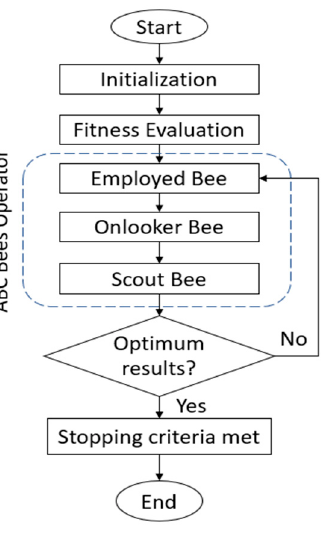
Figure 1. The adaptive neuro-fuzzy inference system (ANFIS) architecture, as adapted from Ref. [40].